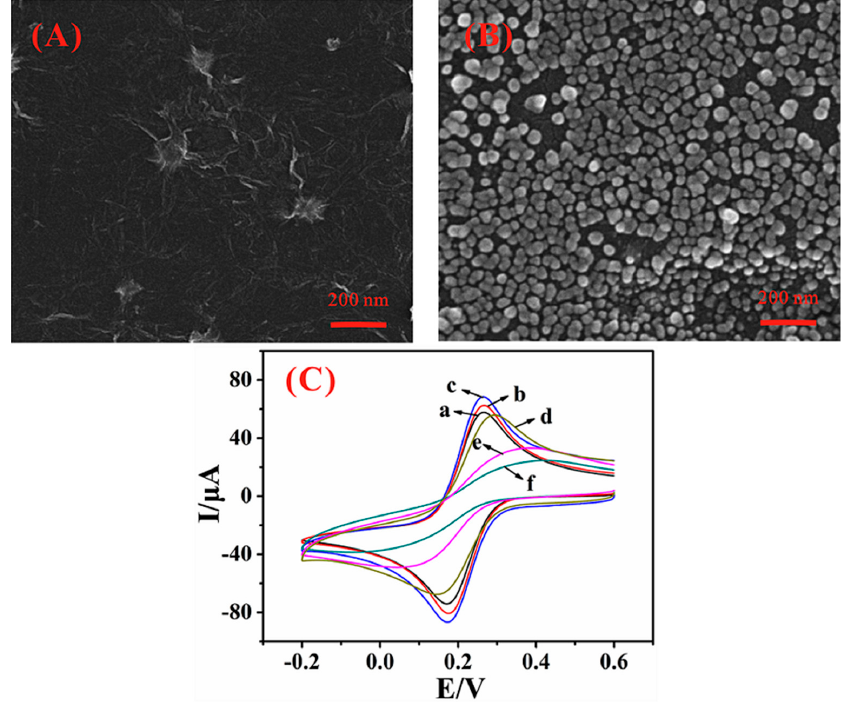
Figure 1. SEM images of ( A ) RGO/GCE and ( B ) AuNPs/RGO/GCE; ( C ) CV diagrams of 5 mM K 3 [Fe(CN) 6 ] and 0.1 M KCl solution at different modified electrodes. Curves: (a) bare GCE; (b) RGO/GCE; (c) AuNPs/RGO/GCE; (d) ssDNA/AuNPs/RGO/GCE; (e) MCH/ssDNA/AuNPs/RGO/GCE; (f) dsDNA/AuNPs/RGO/GCE.